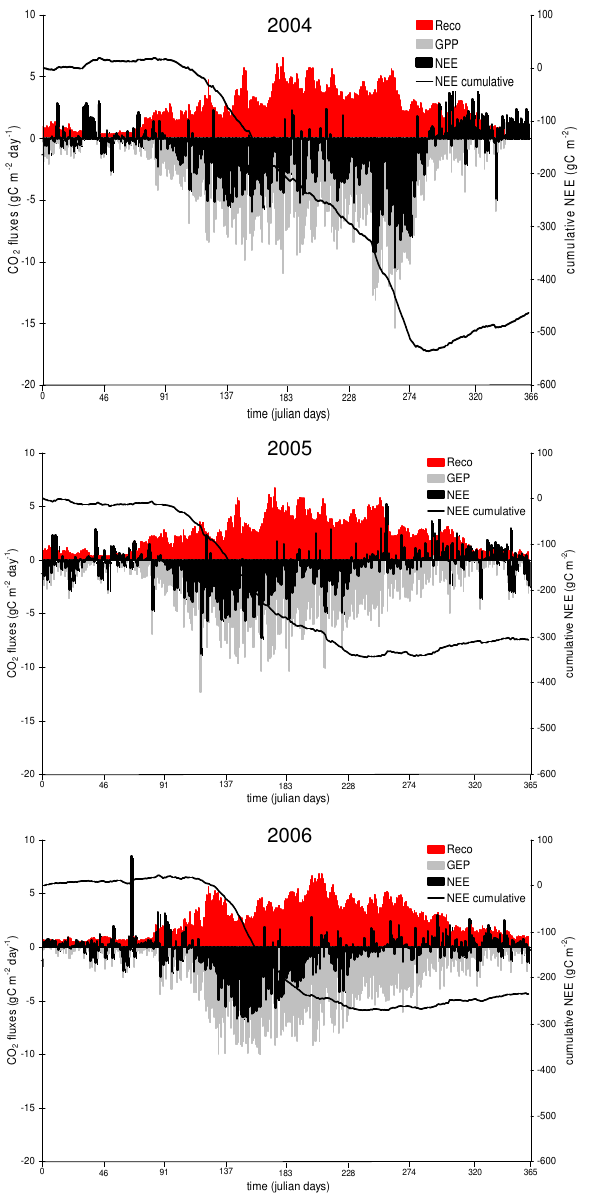
Figure 5: Daily NEE, GEP, R eco and cumulative NEE over the year for 2004 (upper graph), 2005 (middle graph) and 2006 (bottom graph).